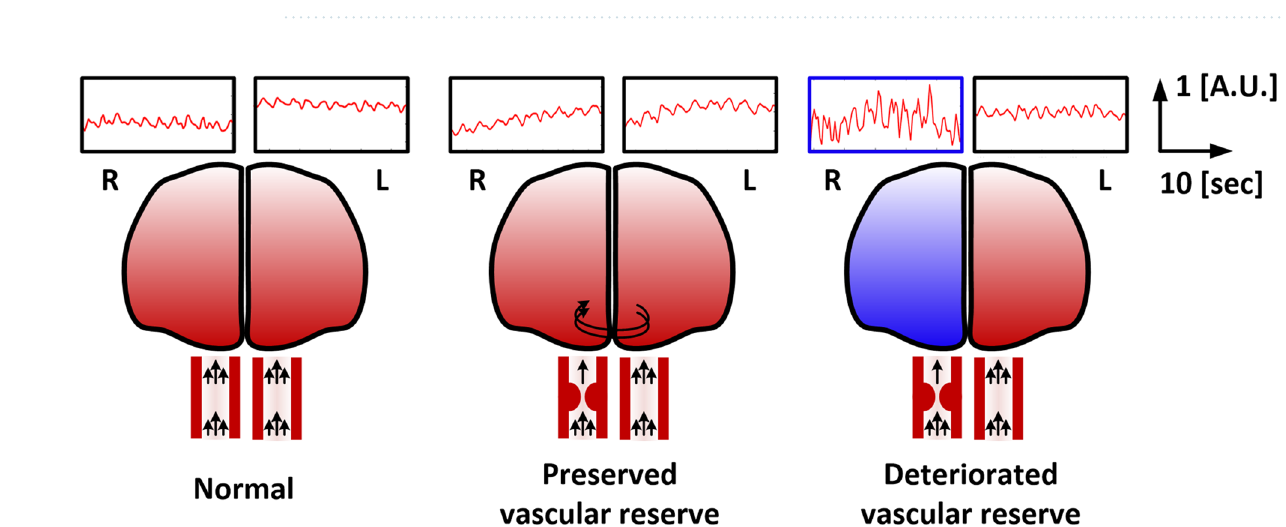
Figure 3. Illustrated waveform of oxyhemoglobin according to the vascular reserve. ΔHbO 2 wave was steeper on ipsilateral to steno-occlusive vessel in patients with deteriorated vascular reserve compared to contralateral side. This asymmetry was not present in patients with intact vascular reserve or controls. This was drawn using three included subjects from each